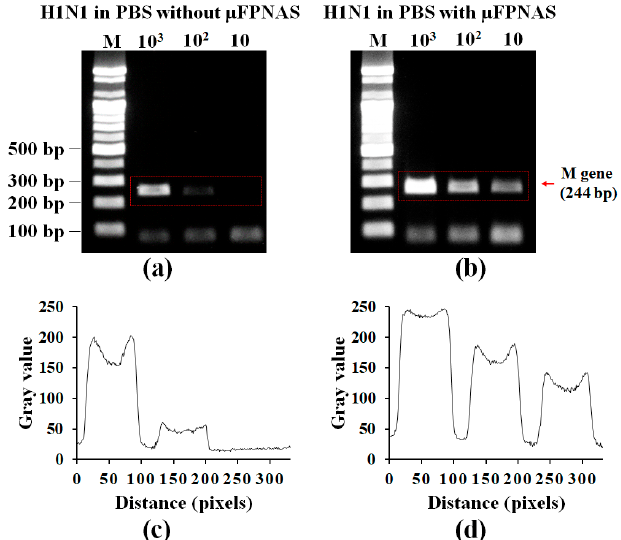
Figure 4. Validation of on-chip preconcentration and RT-PCR of H1N1 in PBS by gel electrophoresis. Gel electrophoresis of PCR products ( M gene) from 1 mL PBS containing influenza A virus H1N1 at different concentration (10 2 –10 4 TCID50/mL) without preconcentration ( a ) and with on-chip preconcentration and RT-PCR using µ FPNAS. ( c , d ) Analysis of the intensity levels at the red rectangular areas in ( a , b ), respectively.